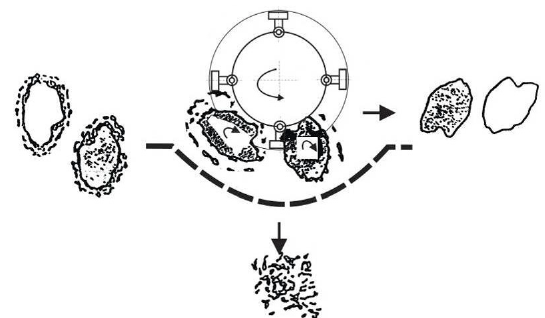
Figure A4. Schematic diagram of matrix release from coatings of used binding material—result of elementary abrasion operation [3].